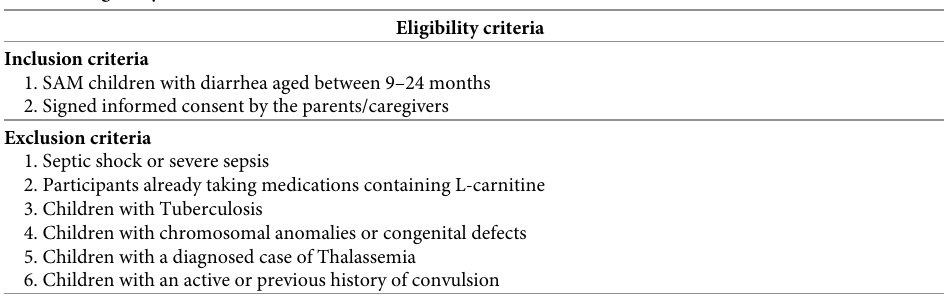
Table 1. Eligibility